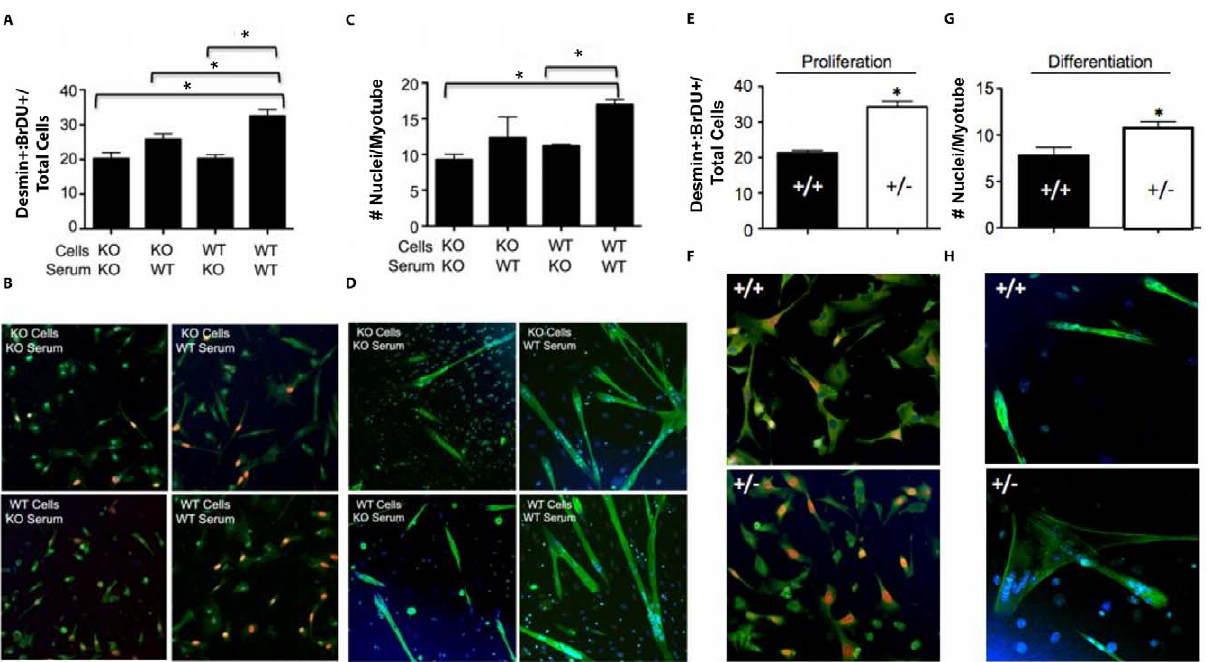
Figure 3. Function of SCs isolated from sphingolipid mutant mice. A) Proliferation of WT and SphK1 KO primary SCs isolated 3 days after NTX injury, measured by BrdU uptake of desmin-positive cells incubated with either SphK1 WT or KO serum. B) Representative immunofluorescence images for experiment in ‘‘A’’. Desmin-stained cells, green; BrdU-stained nuclei, orange. C) Differentiation of SC-derived myoblasts as shown by myotube formation. D) Representative immunofluorescence images for experiment in ‘‘C’’. Hoechst-stained nuclei, blue; eMHC-stained fibers, green. E) Proliferation of SPL heterozygous null ( + / 2 ) and littermate control ( + / + ) mouse primary SC isolated 3 days after injury. F) Representative images for experiment in ‘‘E’’. Desmin-stained cells, green; BrdU-stained nuclei, orange. G) Differentiation of heterozygous null ( + / 2 ) and littermate control ( + / + ) mouse SC. H) Representative immunofluorescence images for experiment in ‘‘G’’. Hoechst-stained nuclei, blue; eMHC-stained fibers, green. * indicates p #